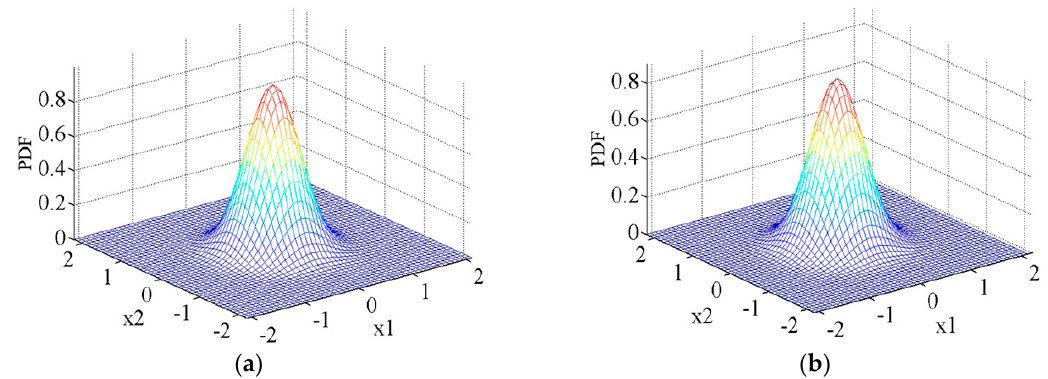
Figure 9. Joint probability density functions (PDFs) of ( x 1 , x 2 ) extracted from the regular path integration (PI) method and from the Monte Carlo simulation (MCS) for the wind condition of Case 3: ( a ) Joint PDFs from the regular PI method; ( b ) joint PDFs from the MCS.